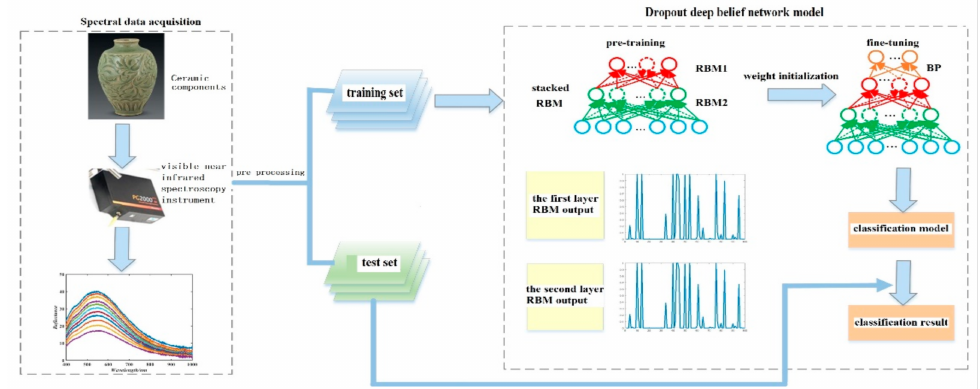
Figure 1. A flow chart of ceramic dating identification in multi-spectral data.